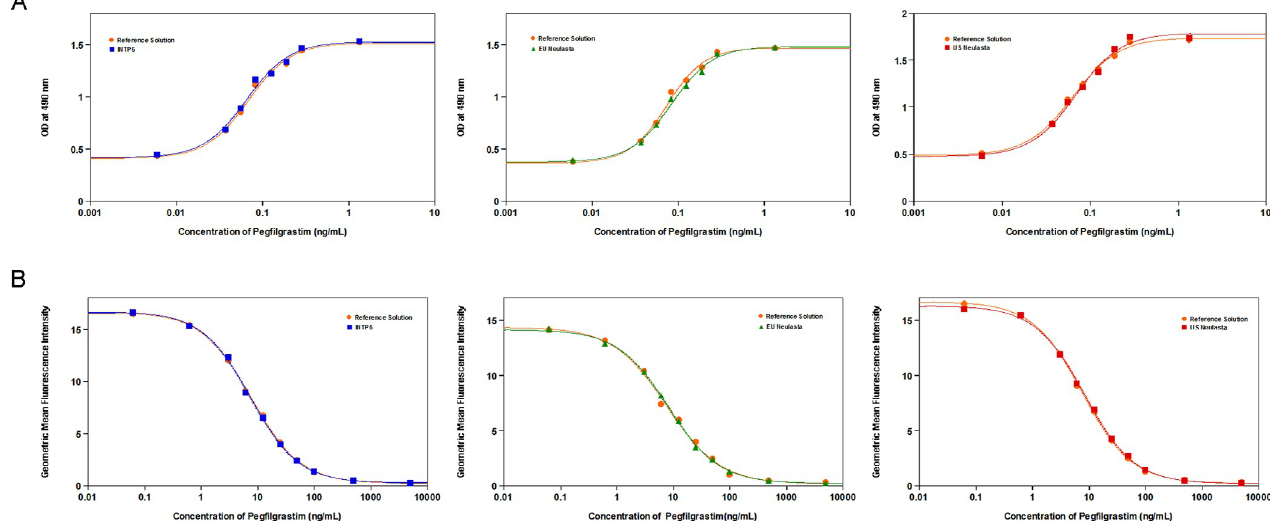
Fig 4. (A) Dose response profile of in vitro cell proliferation assay; (B) Dose response profile of receptor binding assay by flow cytometry.